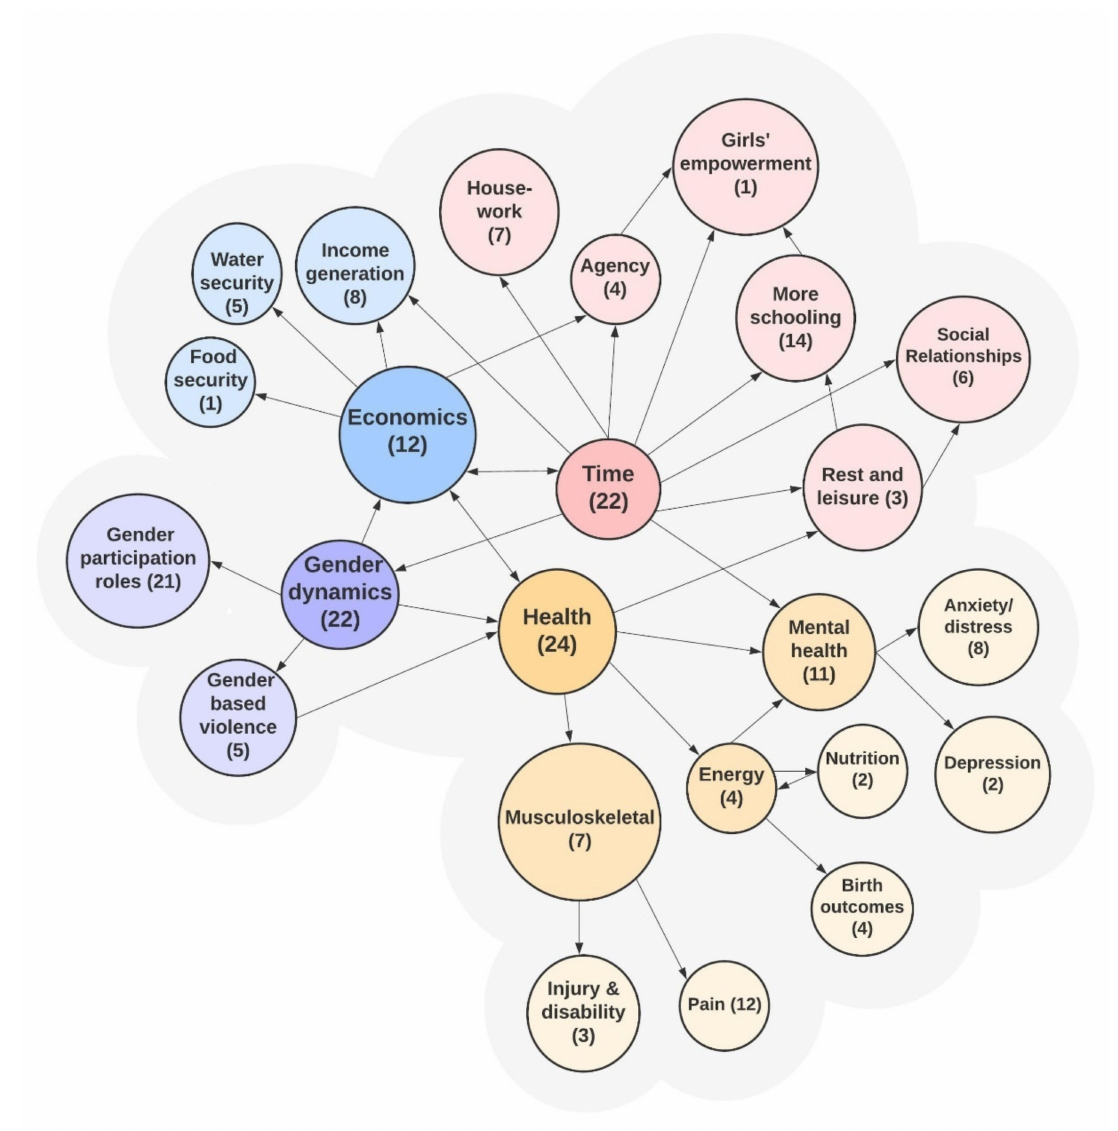
Figure 2. Human health & well-being impacts across different domains described within the literature. The number in each node indicates the number of studies addressing each domain within the review; colors indicate categorization of impacts under broad themes of health, time, gender dynamics, and time with arrows indicating connections between study areas revealed by the